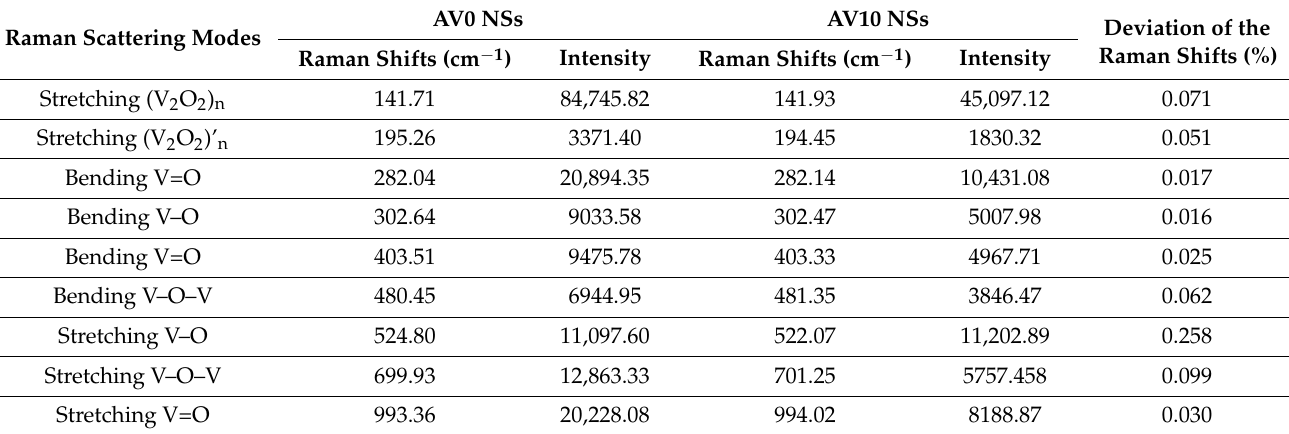
Figure 4. ( a ) Raman spectra of the AV0 and AV10 NSs, and ( b ) schematic V 2 O 5 molecular Scheme [38]. Table 3. Characteristic Raman shifts of the nanostructures of AV0 and AV10